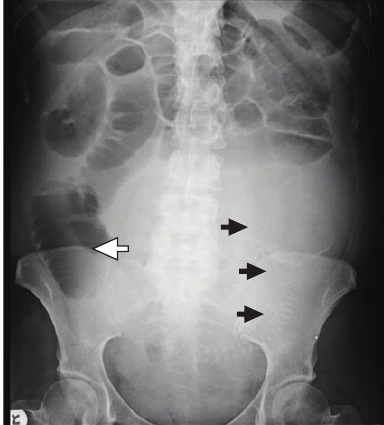
Figure 3: Operative photograph, after releasing obstructive bands. The ileocecal complex and the entire right colon are upside down. The transverse colon passes behind the mesenteric root. Note: the surgeon’s index finger indicates the point of obstruction (arrow).